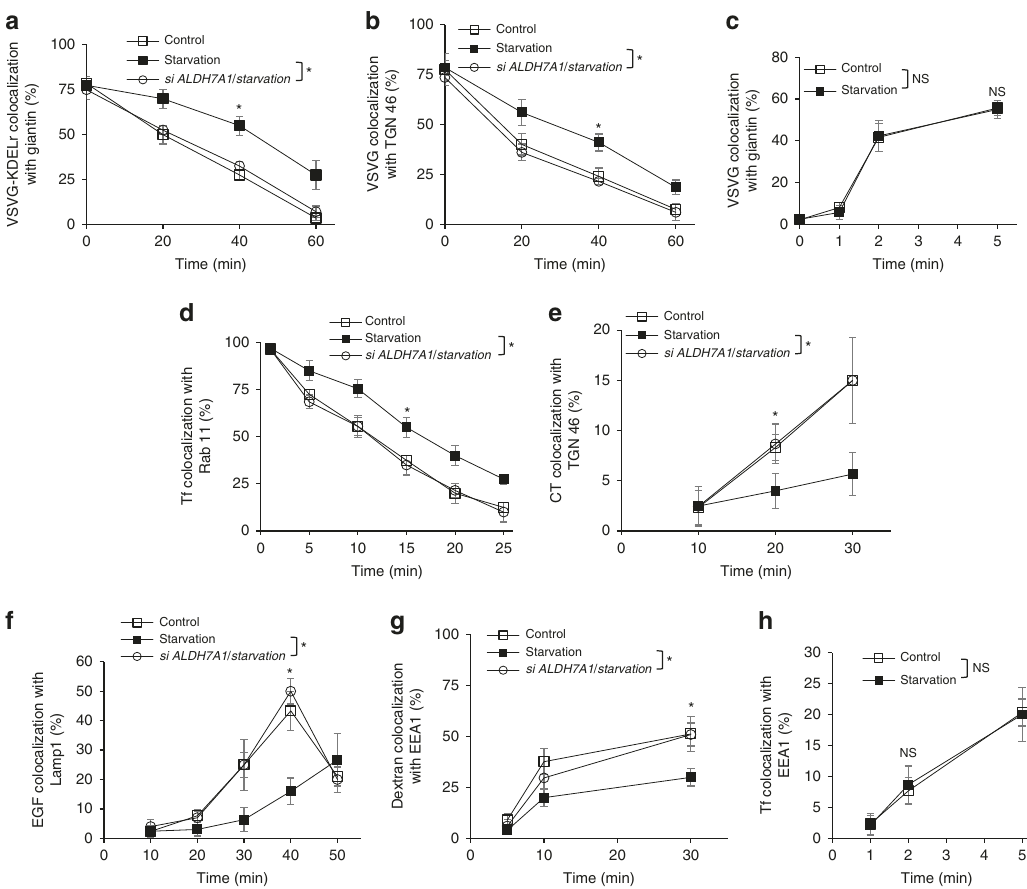
Fig. 6 Starvation inhibits the identical pathways targeted by ALDH7A1. Quantitative results are shown as mean with standard deviation; * p < 0.05, NS not signi fi cant, paired two-tailed Student ’ s t -test; n = 3 independent experiments. Source data are provided as a Source Data fi le. HeLa cells were assessed for the following transport pathways: a COPI transport from the Golgi to the ER was assessed through the quantitative colocalization of VSVG-KDELR with a cis -Golgi marker (giantin). b Transport of VSVG from the Golgi to the plasma membrane was assessed through the quantitative colocalization of VSVG with a TGN marker (TGN46). c Transport of VSVG from the ER to the Golgi was assessed through the quantitative colocalization of VSVG with a cis -Golgi marker (giantin). d Endocytic recycling of Tf from the recycling endosome (RE) to the plasma membrane was assessed through the quantitative colocalization of internalized Tf with a recycling endosome marker (Rab11). e Endocytic transport of CT to the Golgi was assessed through the